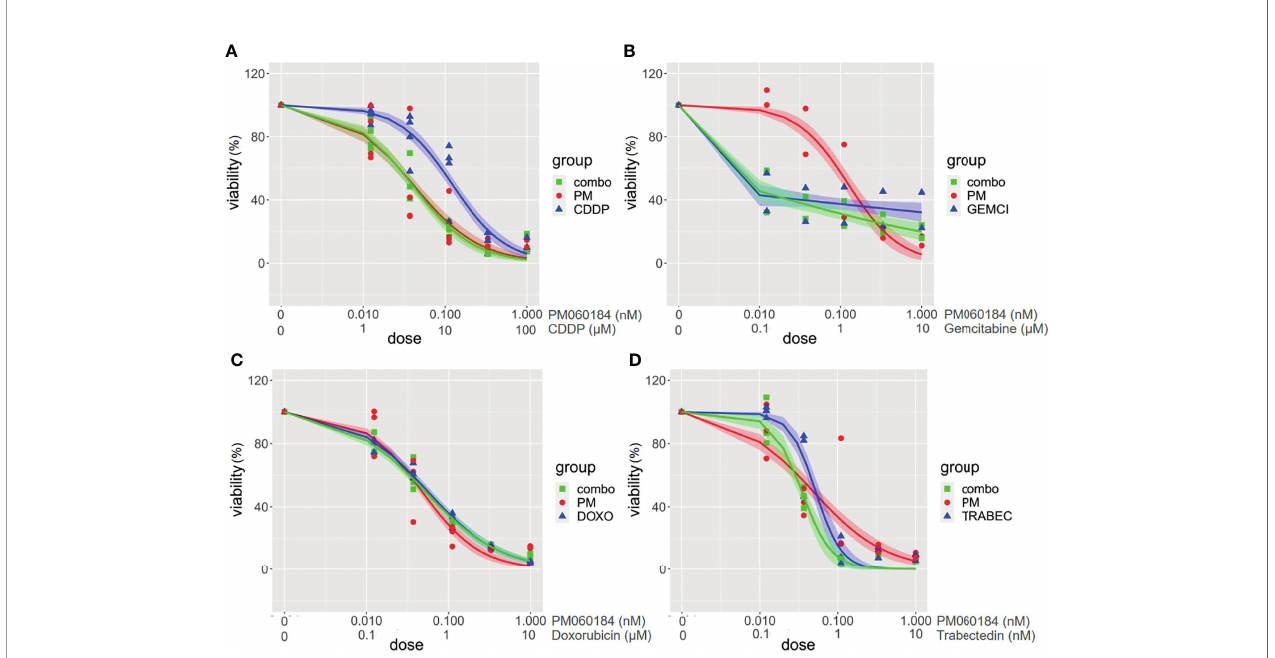
FIGURE 6 | Drug combination assays in OV866(2) cell line. Graphs represent viability curves for individual drugs (PM060184: red; cisplatin (CDDP), doxorubicin, gemcitabine or trabectedin: blue, and for combinations: green). Range concentration of each drug are described in the X-axis. PM060184 was combined